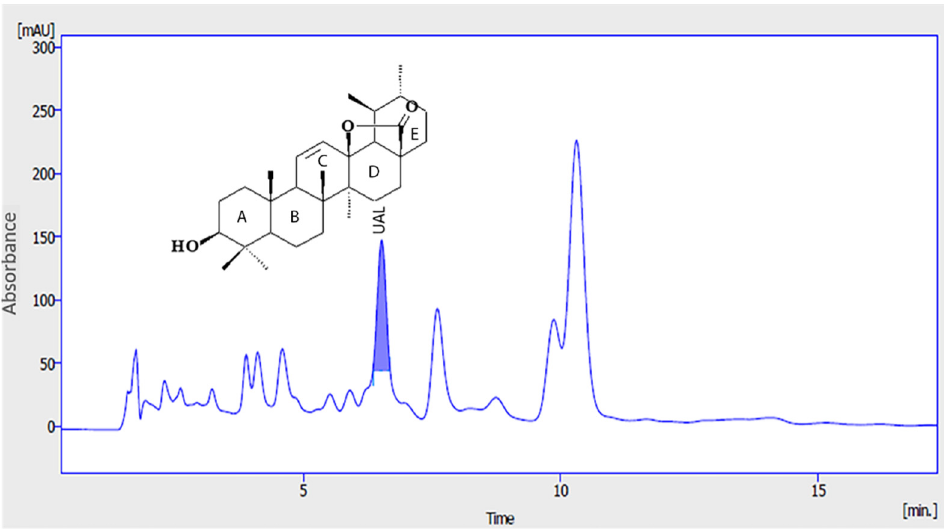
Figure 8. Chromatogram of Eu extract. Chromatographic profile of E. tereticornis leaves extract. UAL: Ursolic acid lactone.